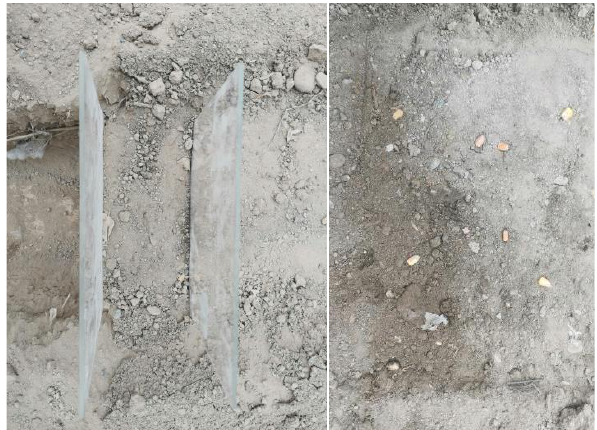
Figure 14. Sampling process.